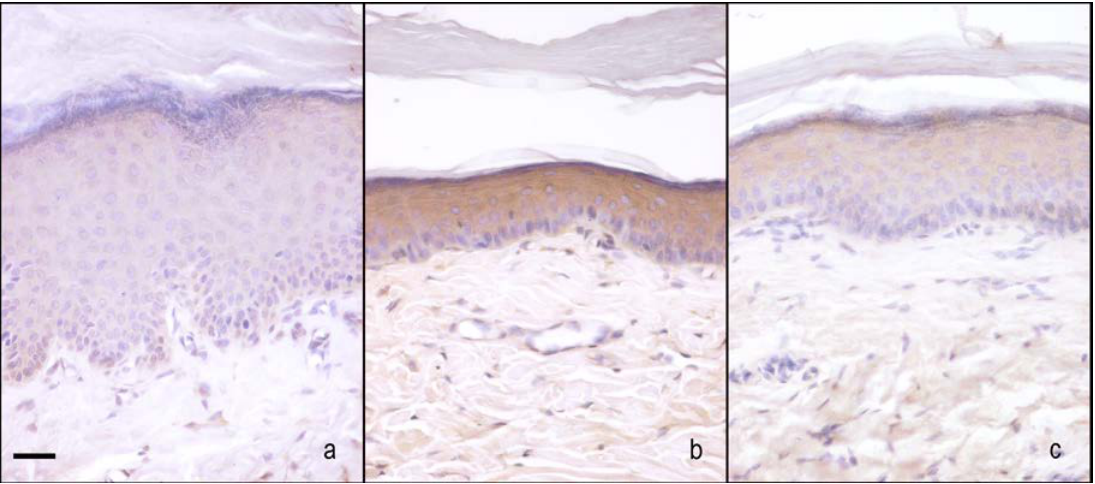
Figure 7. Microphotographs of iNOS immunostaining in plantar skin. Microphotographs of iNOS immunostaining in the epidermis of the right hind-paw plantar skin of sham-operated rats treated with 1% ethanol in saline (vehicle for melatonin) ( a ), CCI rats treated with 1% ethanol in saline (vehicle for melatonin) ( b ), and CCI rats treated with melatonin 10 mg/kg ( c ). Bar = 20 µ m.